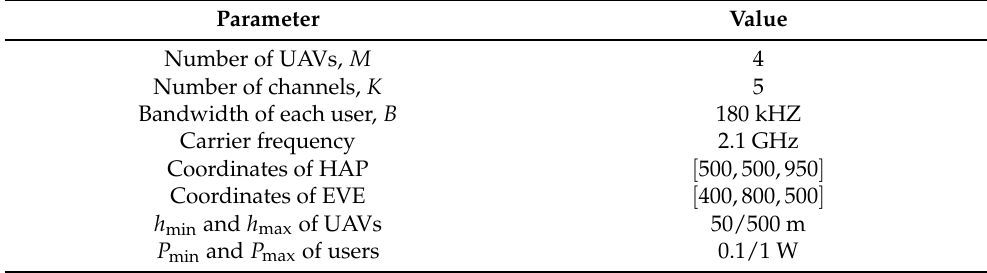
Table 2. Simulation